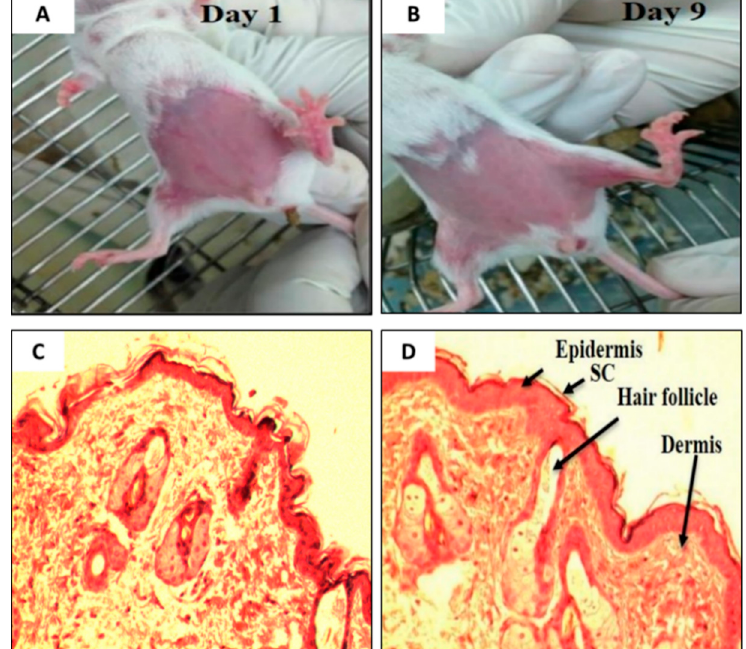
Figure 2. Visual inspection on the BALB/c mice on ( A ) Day 1 and ( B ) Day 9. ( C ) Photomicrograph